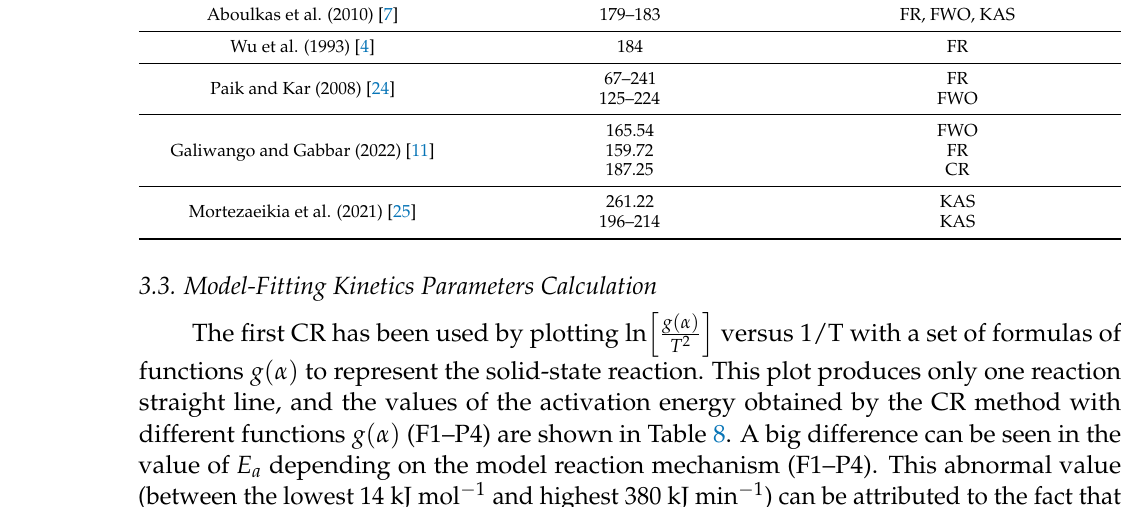
Table 7. Activation energies of PP obtained by different published papers.